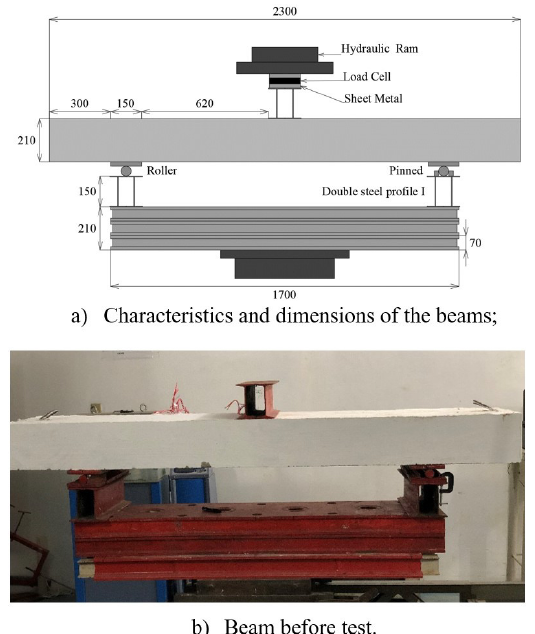
Figure 3 – Characteristics and dimensions of the tested